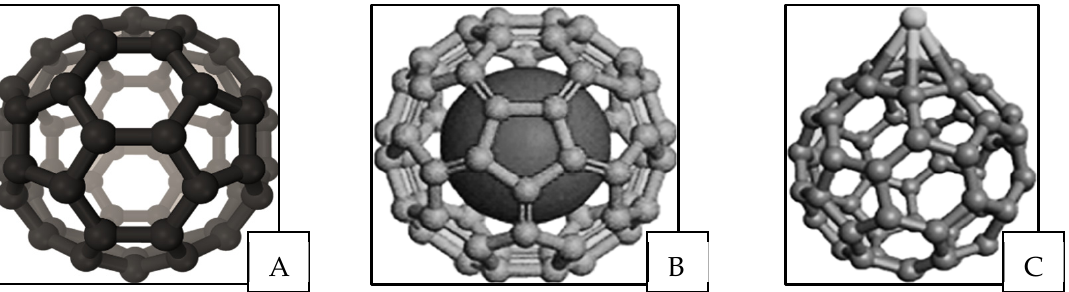
Figure 10. Structure of ( A ) buckminsterfullerene molecule, C60, metallofullerenes, ( B ) endohedral, ( C ) exohedral.